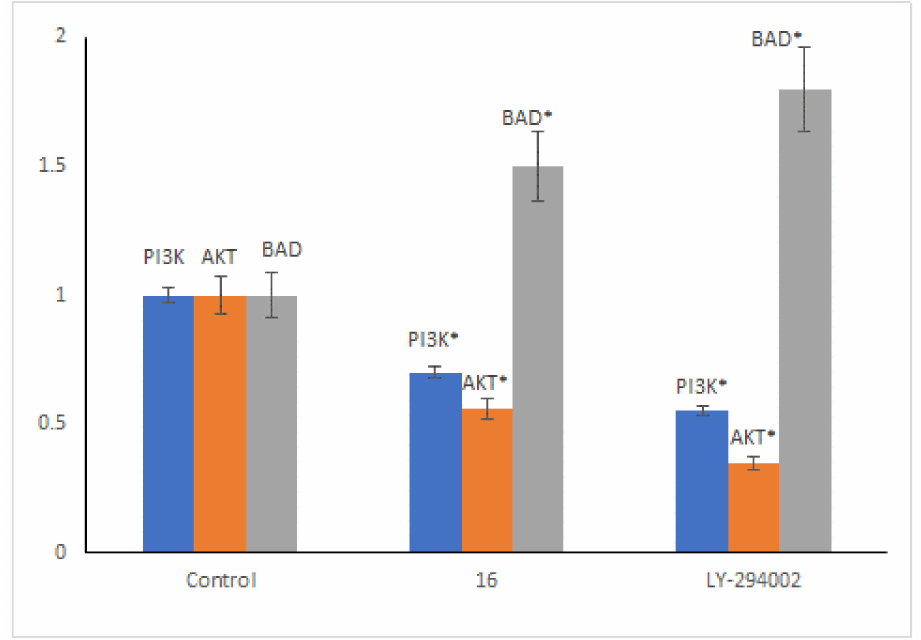
Figure 3. Relative gene expression of PI3K, AKT, and BAD in HCT116 cells after treatment with Compound 16 and the positive control LY-294002. Bars represent mean values ± SEM (lines) of three replicates. Asterisks represent significant change relative to the negative control (* p <